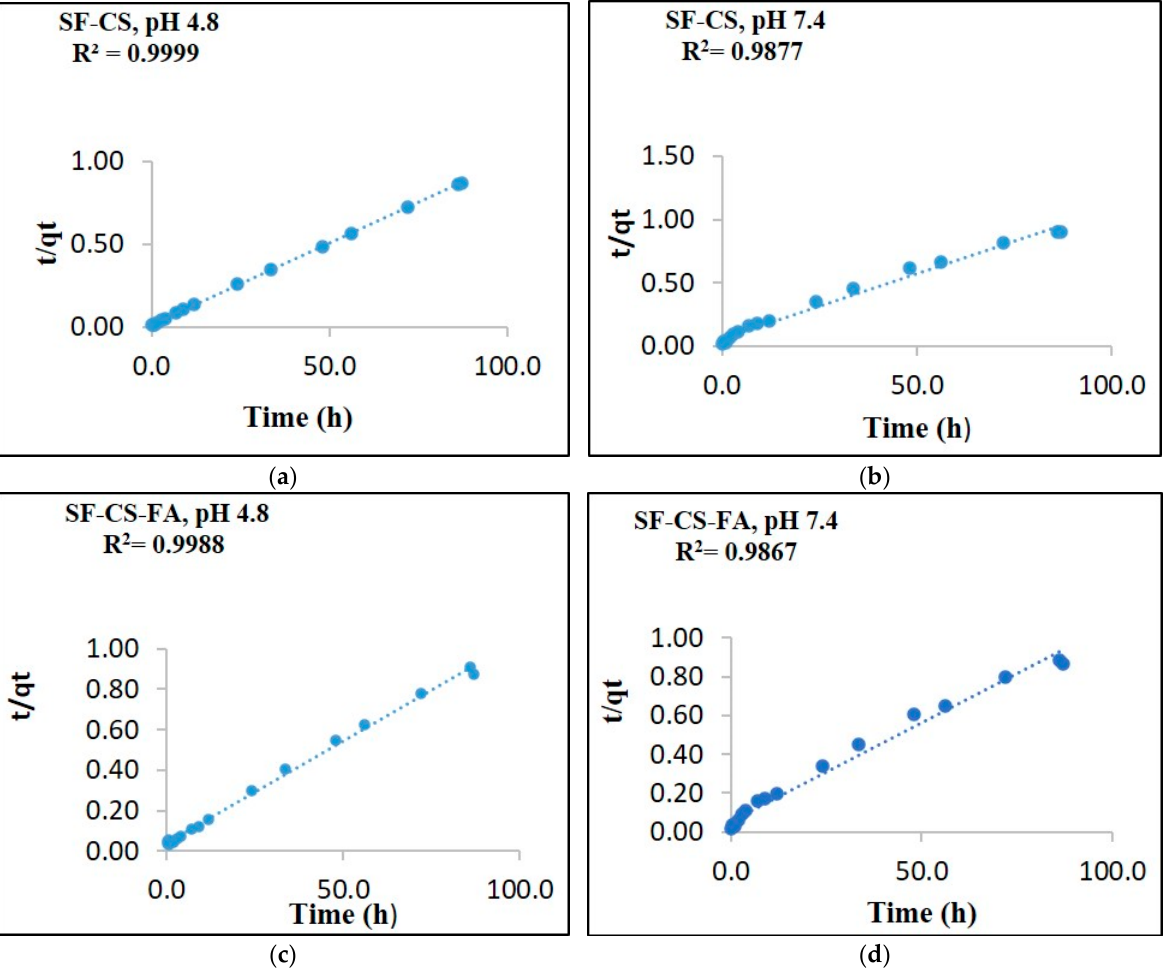
Figure 12. The data fitting of SF release from its SF-CS nanoparticles at pH 4.8 ( a ), pH 7.4 ( b ) and its SF-CS-FA nanoparticles at pH 4.8 ( c ), pH 7.4 ( d ) using the pseudo-second-order kinetics models. Table 5. Correlation coefficient value (R 2 ) of kinetics release of SF from its SF-CS and SF-CS-FA nanoparticles into PBS solutions at pH 7.4 and 4.8 using the first-order, pseudo-first-order, pseudo-second-order kinetics, Higuchi, Hixon-Crom- well, and Korsmeyer Peppas models and the pseudo-second-order rate constant, K 2 (mg/min).